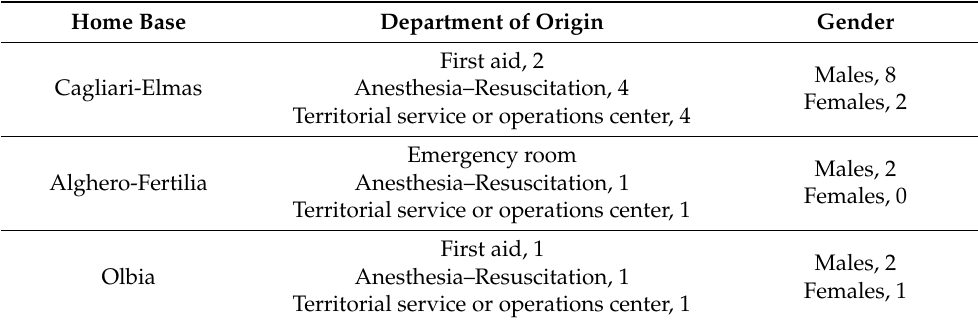
Table 1. Home base, department of origin and gender of